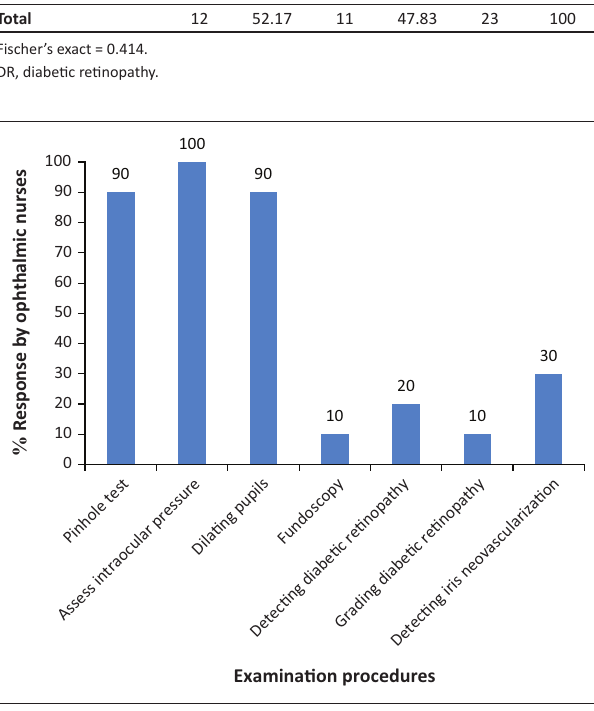
FIG URE 5: Percentage of self-reported competency level of ophthalmic nurses in conducting examination procedures.